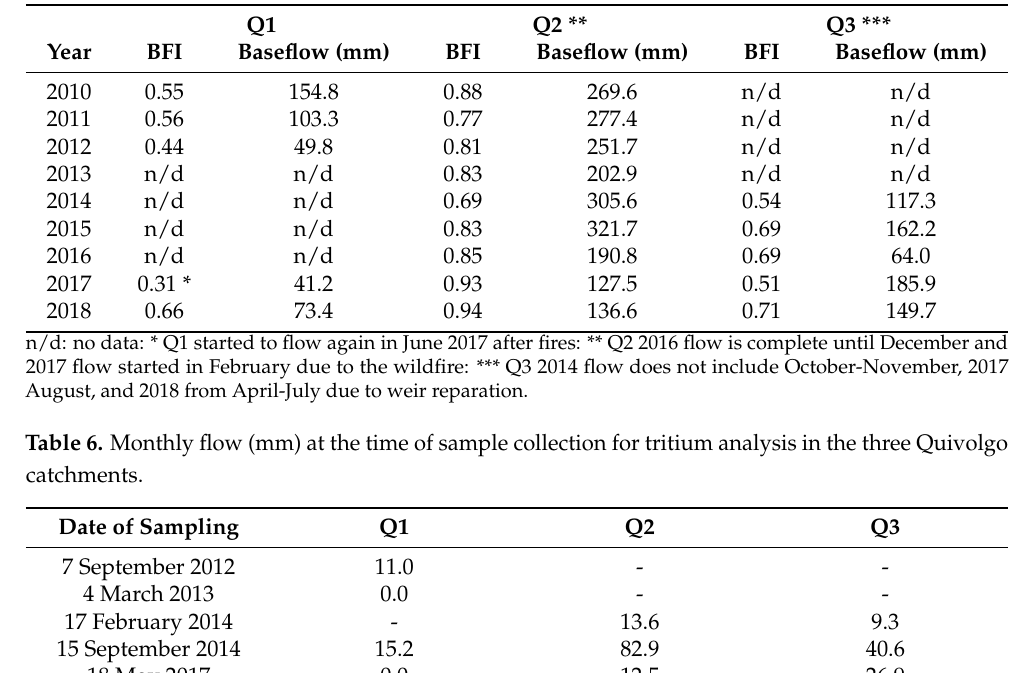
Table 5. Proportion of baseflow over total flow within each catchment.